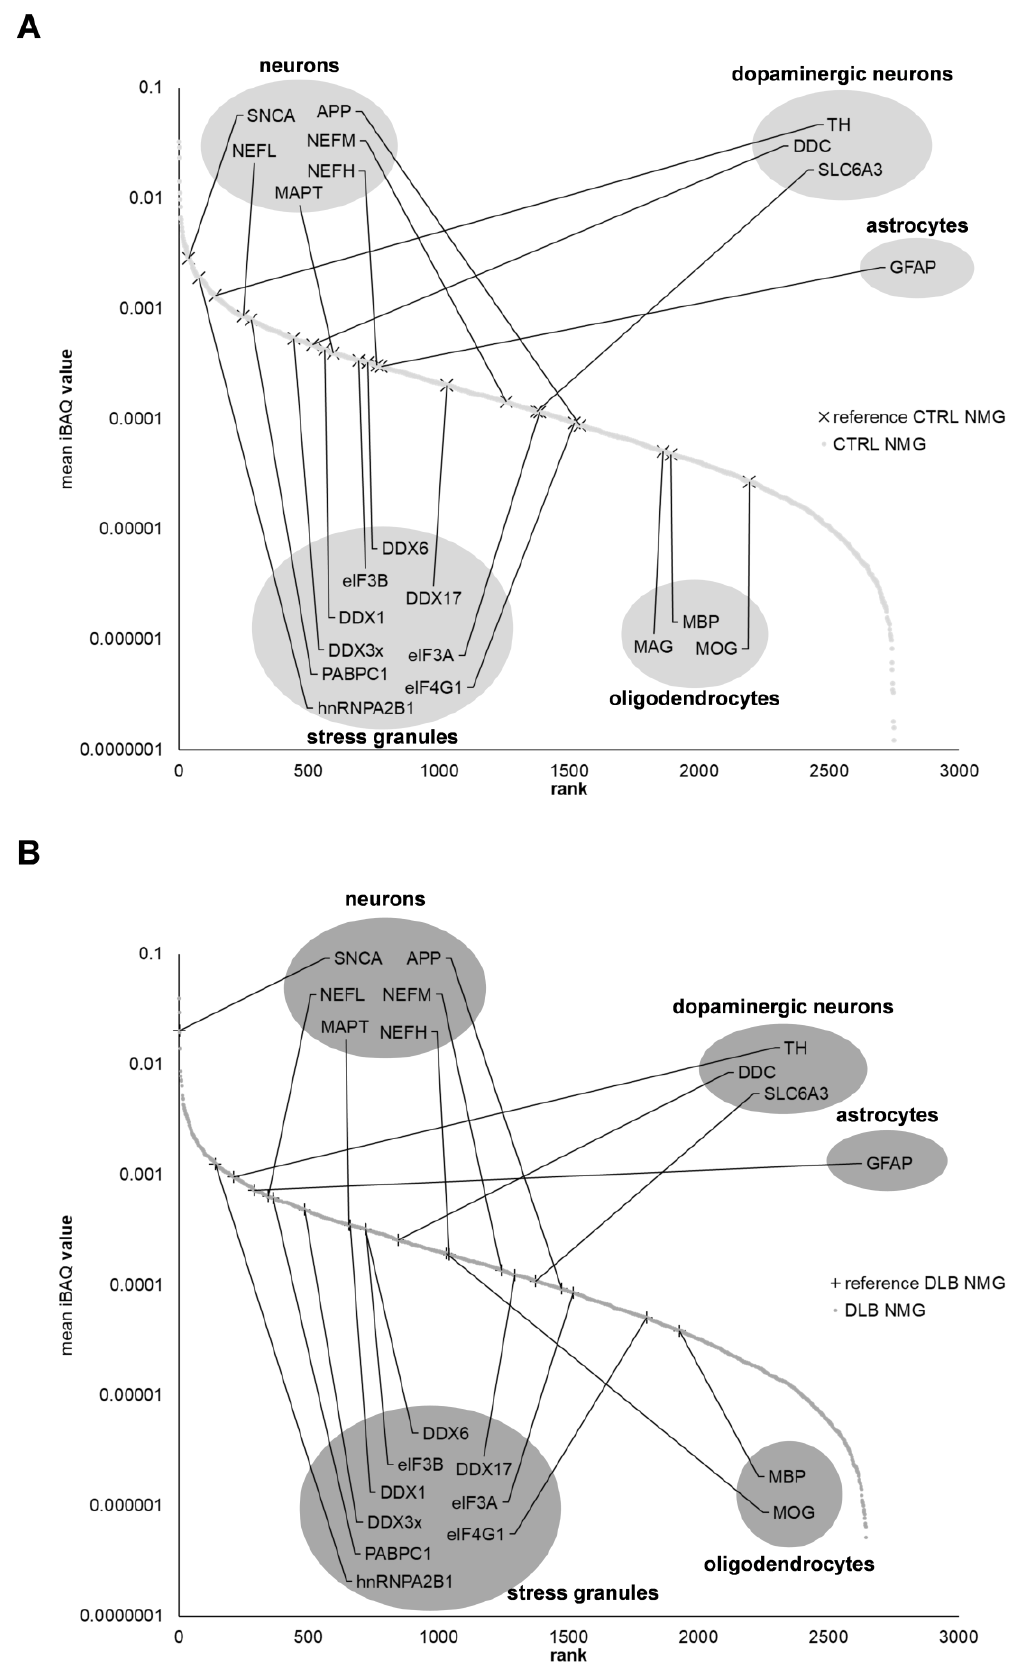
Figure 4. Ranking of protein expression intensities in NMGs of both conditions. Plots display the normalized mean iBAQ-values of identified proteins in NMGs of CTRL ( A ) and DLB ( B )